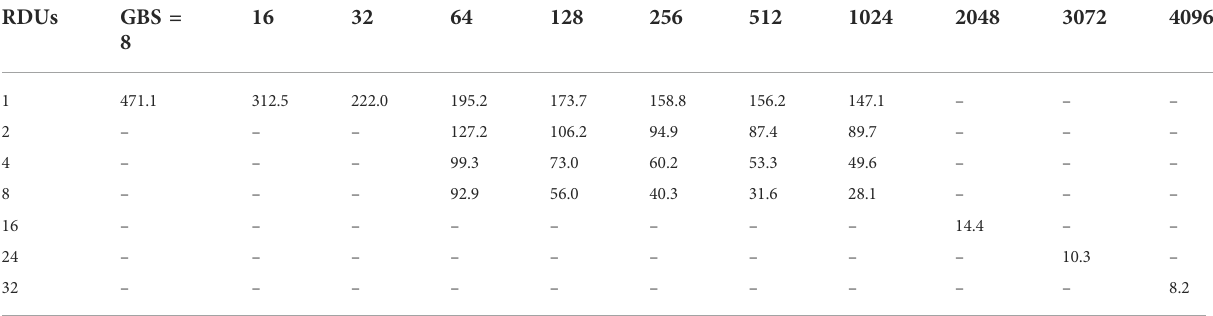
TABLE 3 Strong scaling, training time in seconds for one epoch with different GBSs using RDUs. Cases not carried out are indicated with dashes.